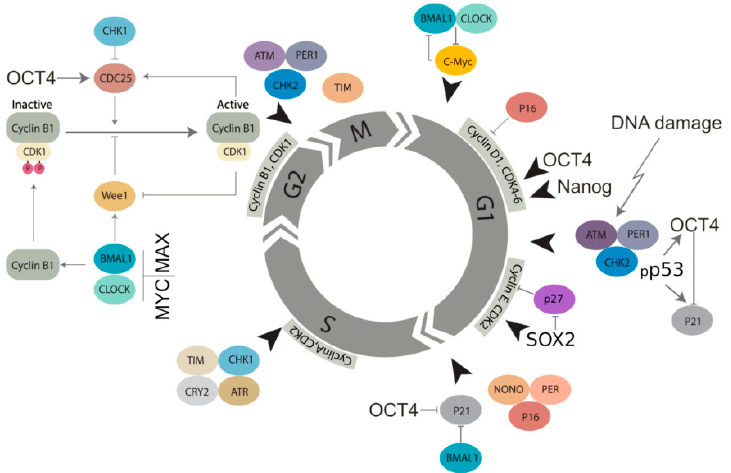
Figure 9. Regulation of the cell cycle and its checkpoints by specific cyclin-dependent kinases and the molecular components of the circadian clock. The role of stemness factors in adapting the normal cell cycle pace (Note: This figure was originally published under CC ‐ BY license in [32].).